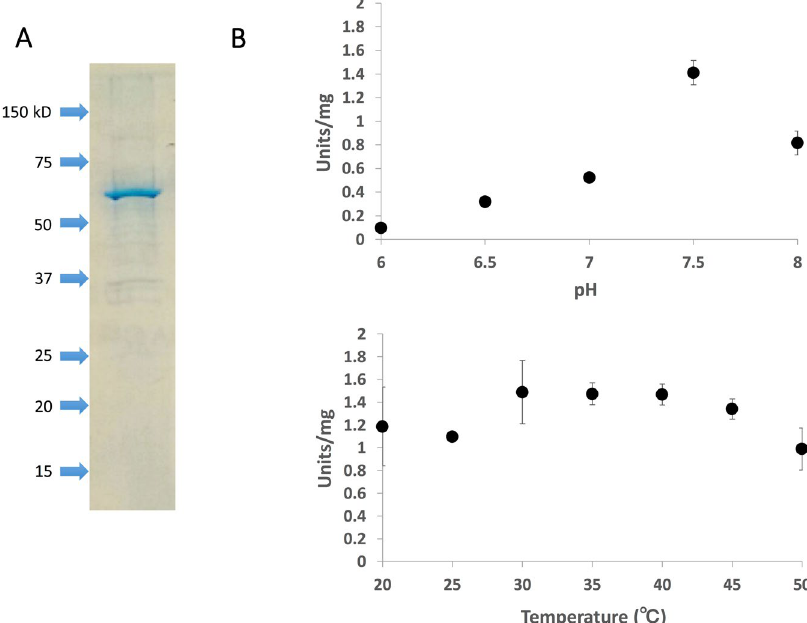
Figure 1. Biochemical analysis of Synechocystis 6803 d-lactate dehydrogenase ( Sy Ddh). ( A ) Purification of GST-tagged Sy Ddh after separation by electrophoresis on a 12% SDS-PAGE gel. The gel was stained with InstantBlue reagent. Arrowheads indicate the molecular weight. ( B ) Effect of pH (top) and temperature (bottom) on Sy Ddh activity. Data represent the relative values of the means from three independent experiments. For the enzyme assay, 60 pmol (or 0.0038 mg) of Sy Ddh was used. One unit of Sy Ddh activity was defined as the consumption of 1 μ mol NADH per